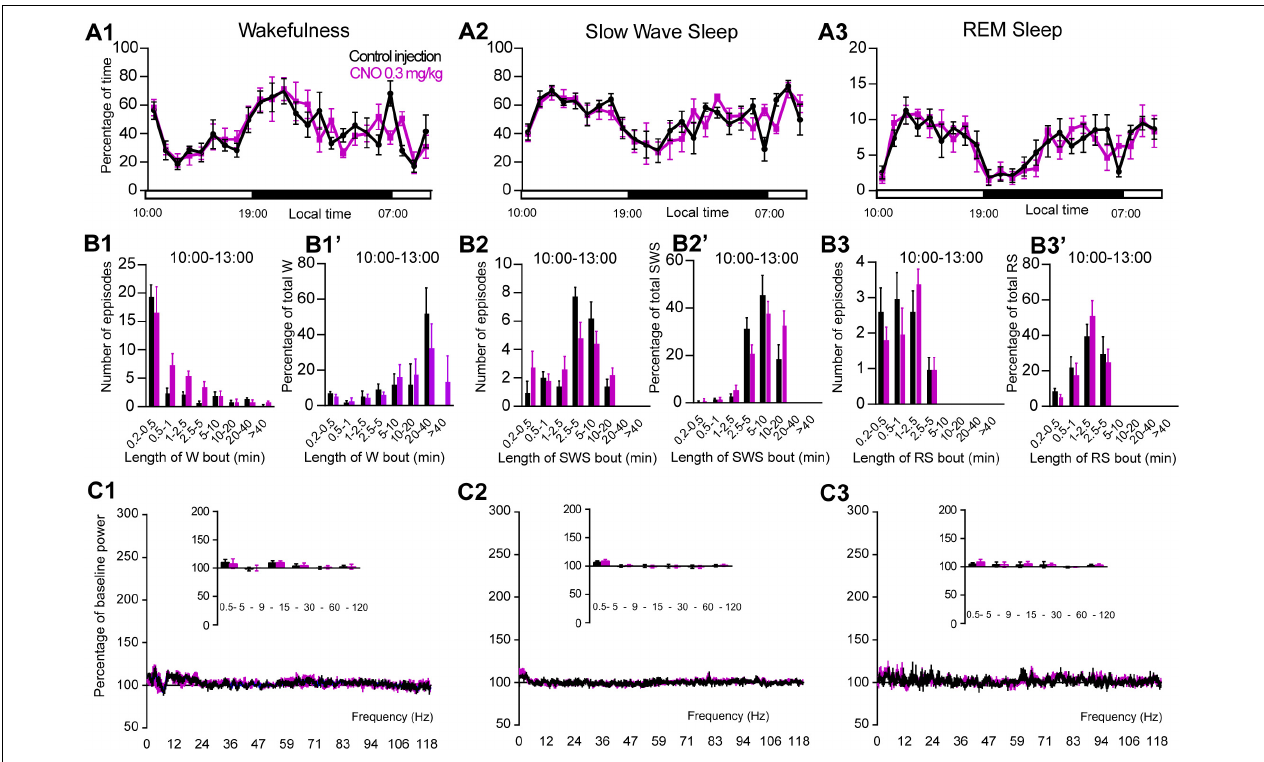
FIGURE 5 | CNO injection (10:00 or ZT3) in control mice. (A) Hourly amount of wakefulness (A1) , SWS (A2) and REM (A3) sleep following CNO (0.3 mg/kg, N = 5 mice) as compared with control injection. (B1–B3) Number of episodes ( ± S.E.M.) of wakefulness (W), SWS or REM sleep (RS) in each bout length and (B1’–B3’) time-weighted frequency histograms showing the proportion ( ± S.E.M.) of W, SWS or RS amounts in each bout length as a percentage of the total amount of W, SWS or RS during the 3 h post-injection period (10:00–13:00; N = 5). (C1–C3) Sleep-wake power spectrum changes over baseline during the 3 h (10:00–13:00) post CNO (0.3 mg/kg, N = 5 mice) injection as compared with control injection; and the quantitative changes ( ± S.E.M.) in power for the δ (0.4–5 Hz), θ (5–9 Hz), α (9–15 Hz), β (15–30 Hz), low γ (30–60 Hz) and high γ (60–120 Hz) frequency bands ( ± S.E.M.) following vehicle or CNO (0.3 mg/kg, N = 5 mice) administrations. Control injection in Black, CNO injection in magenta; no significant change, two-way ANOVA followed by a post hoc Bonferroni test.